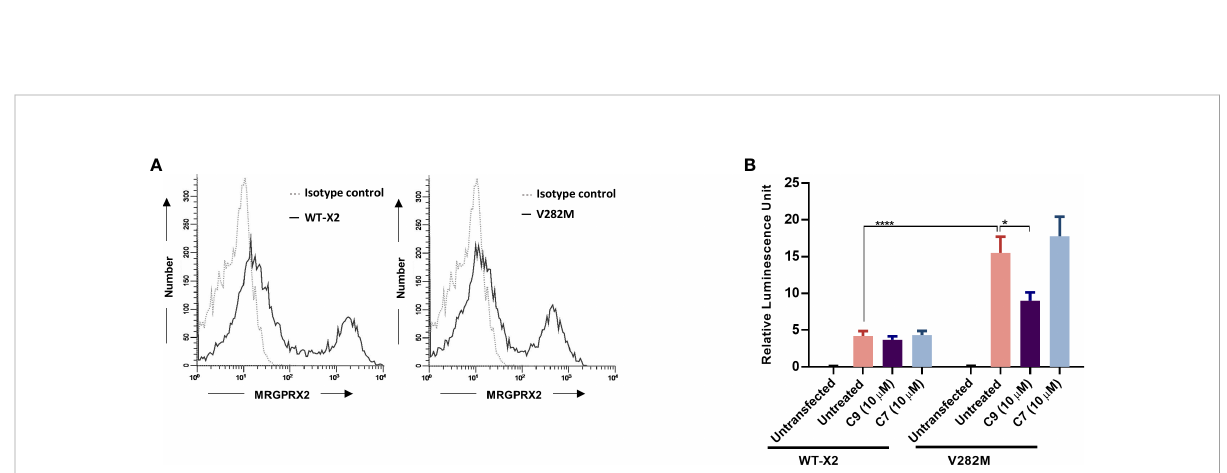
FIGURE 7 Constitutive b -arrestin recruitment in response to a naturally occurring missense MRGPRX2 variant is inhibited by C9. (A) HTLA cells transiently expressing MRGPRX2 (WT-X2) and its variant V282M were incubated with PE-conjugated anti-MRGPRX2 antibody or isotype controls and the cell surface receptor expression was determined by fl ow cytometry. (B) Cells were exposed to C9 (10 µM) or C7 (10 µM) without any agonist stimulation. After 16 h, the medium was removed and substituted with Bright-Glo solution (100 m l/well) in a 96-well plate. b -arrestin gene translocation-mediated gene expression was measured in a relative luminescence unit. Data are expressed as mean ± SEM. Statistical signi fi cance was determined by two-way ANOVA test at a value * P < 0.05 and **** P < 0.0001.